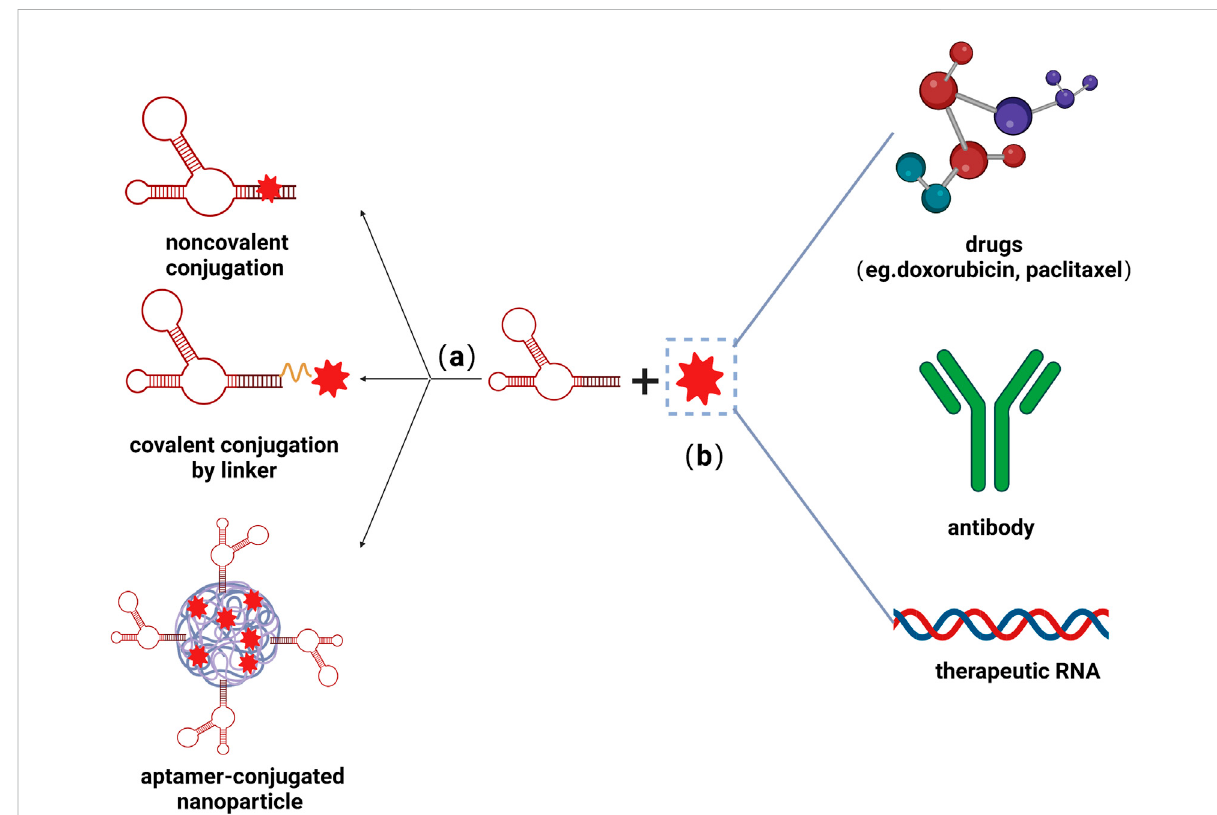
Schematic illustrations of aptamer-functionalized delivery system. (A) Nucleic acids can couple with small molecules via noncovalent conjugation, covalent conjugation by linker, as well as co-conjugate on the surface of nanoparticles. (B) Aptamers could be conjugate with various therapeutic molecules, including drugs, antibodies, and RNAs, greatly improving the ef fi cacy of treatment. Created with